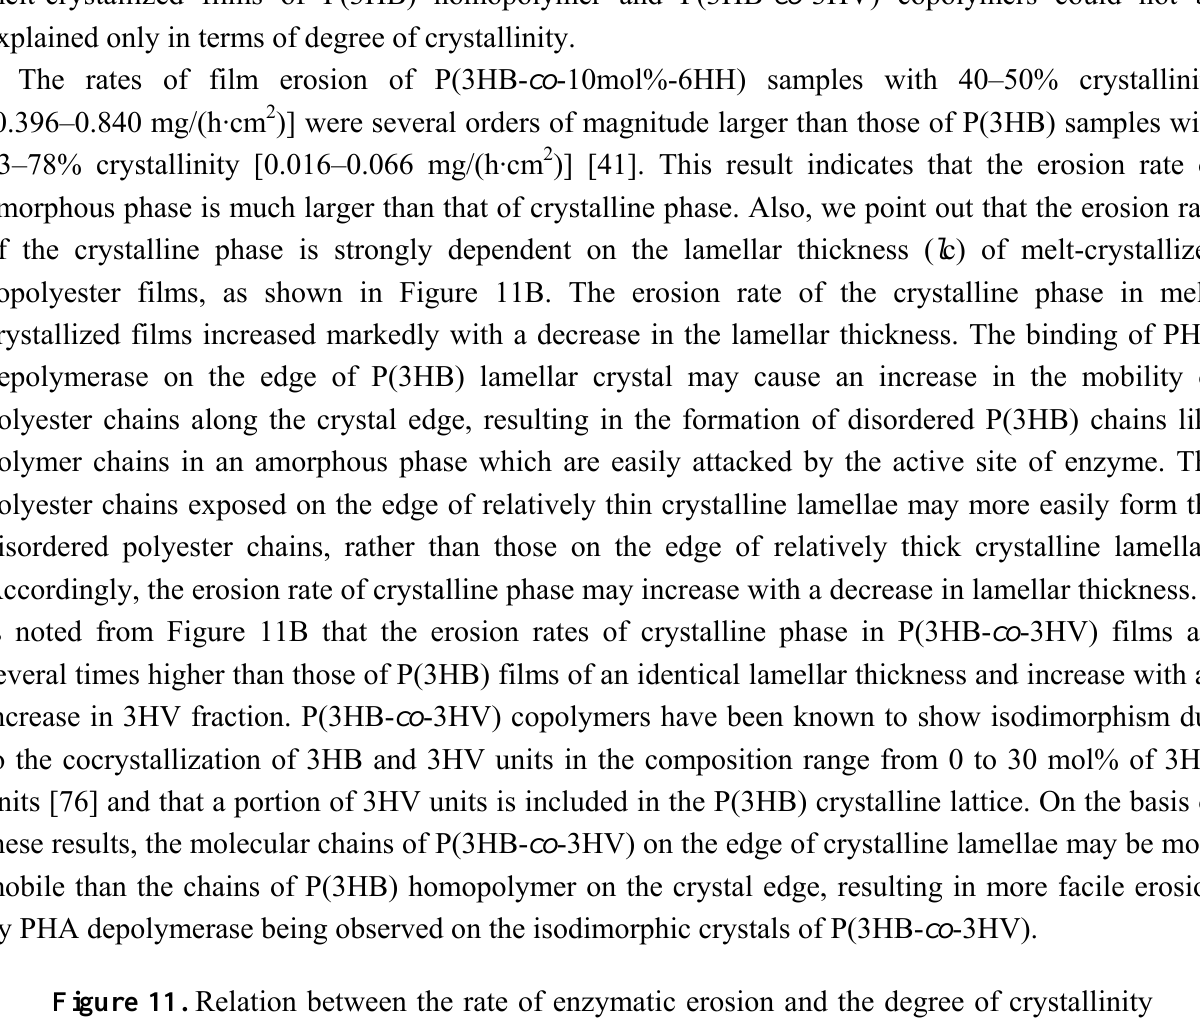
(Xc) (A) and the lamellar thickness (B) for melt-crystallized PHA films and solvent-cast, stretched, and stretched-annealed UHMW-P(3HB) films. [41,74] Reproduced